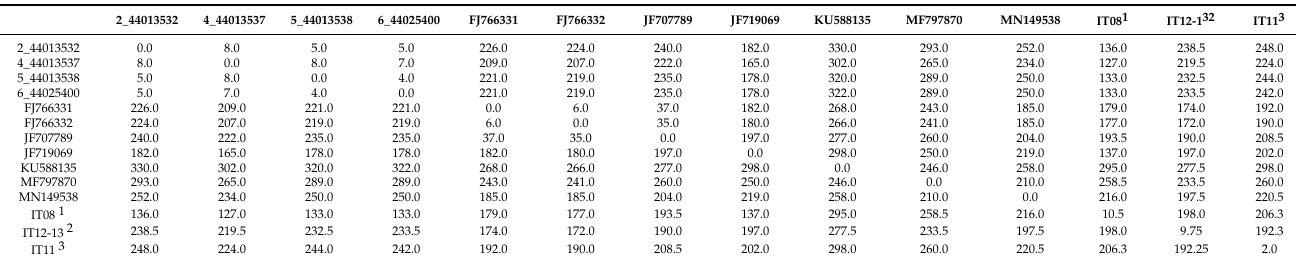
Figure 2. Sequences of the Spanish 2020 WNV outbreak (pale blue); the closest relatives from previous outbreaks in Italy IT08, IT11, IT12-13 (dark blue); and the sequence JF719069 from a lethal equine case in Andalusia (Spain) in 2010. Other Spanish outbreaks were: JF707789, from a mosquito in Huelva, and FJ766331 and FJ766332, from a golden eagle in Toledo [14]. Other related outbreaks from the Mediterranean region (Cyprus MF797870) [13], or adjacent locations (United Arab Emirates KU588135 and Russia MN149538) are also included. Confidence intervals for the times at which the branching points occurred are marked with bars. Branching points are labeled for the discussion. Table 2. Genetic distances observed among the WNV of the current outbreak and the closest sequences in the phylogeny in terms of nucleotide differences. IT08, IT12-13, and IT11 refer, respectively, to the 2008, 2012–2013, and 2011 Italian outbreaks, with several sequences. The values are average distances between all the sequences in the cluster and the compared